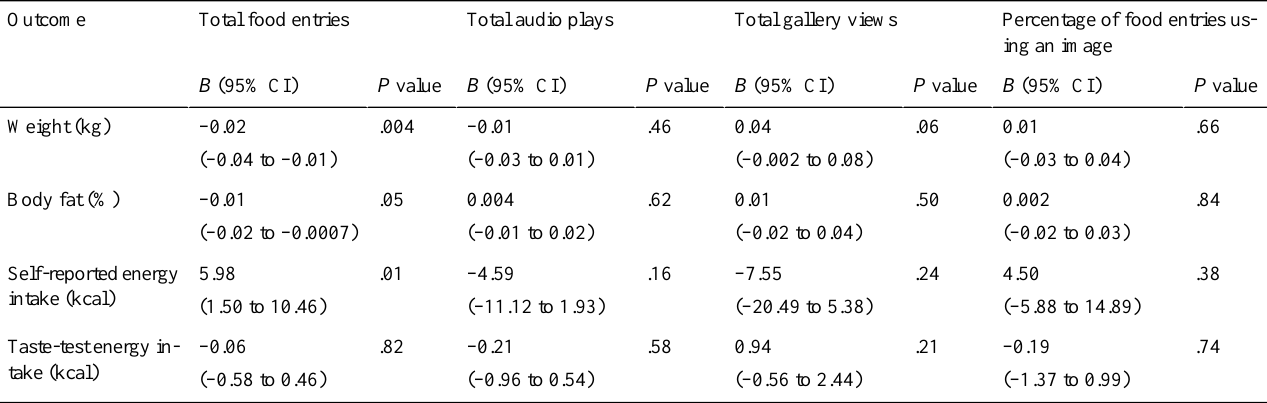
Table 3. Regression results for app usage variables as predictors of trial outcomes at 8